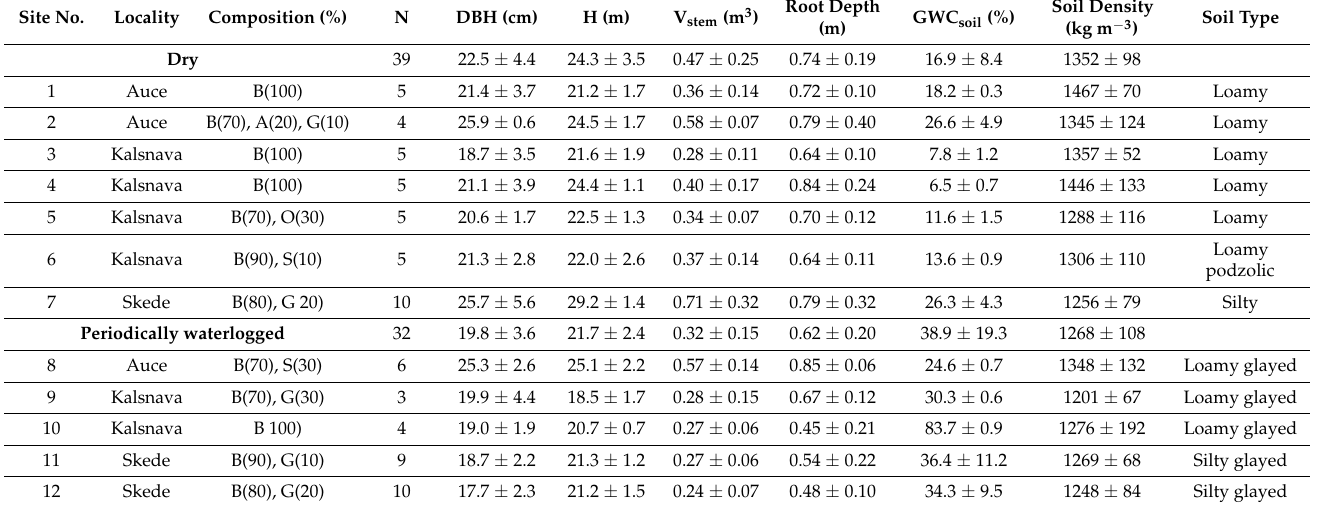
Table 1. Tree species composition (number in brackets show relative amount according to standing volume), mean ( ± standard deviation) diameter at breast height (DBH), height (H), and stem-wood volume (V stem ) of sample trees (Tree N), root depth, and the mean ( ± standard deviation) gravimetric water content of soil (GWC soil ) of each sampled site. Tree species abbreviated as